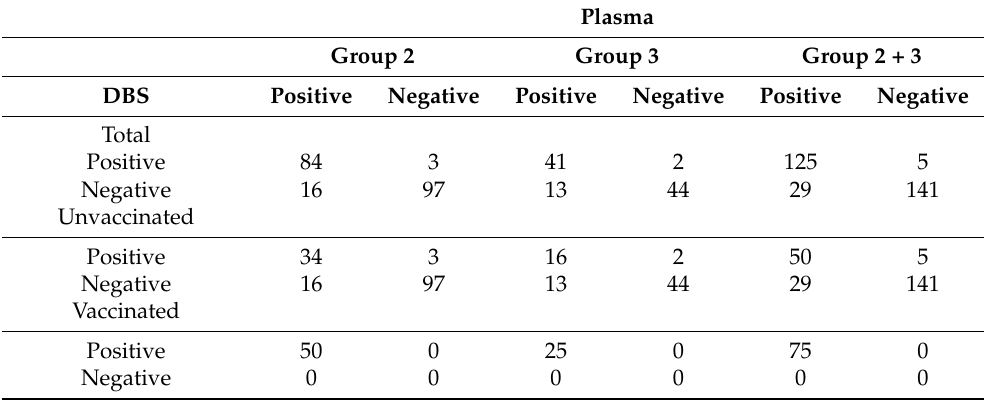
Table 2. Qualitative results from paired plasma samples (used as gold standard) and DBS in vacci-